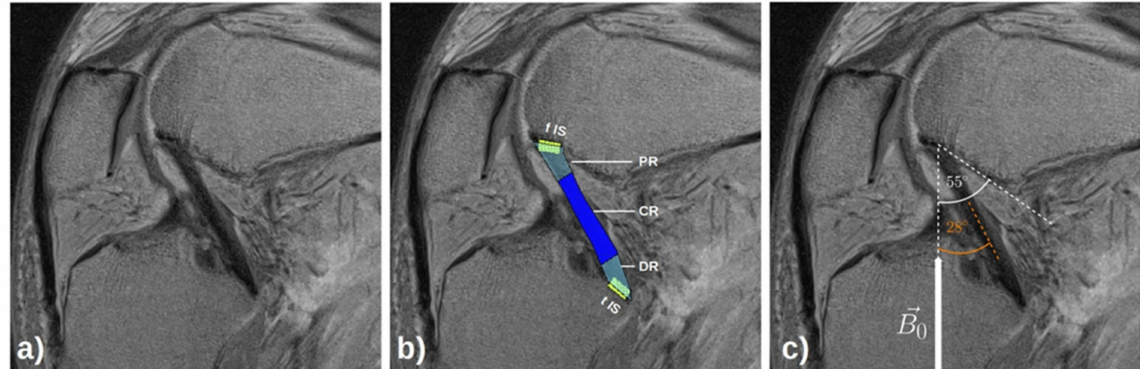
Figure 2. Exemplary visualization of the osseous and ligamentous regions-of-interest of the posterior cruciate ligament (PCL) and the orientation of the PCL to the main magnetic field B 0 . On the corresponding morphologic parasagittal image with moderate T2-weighting (echo time = 41.4 ms) ( a ), the PCL was identified and manually segmented. The PCL’s segmentation outline was automatically divided into quarters for further subregional analysis ( b ). The proximal 25% of the PCL was defined as the proximal subregion (PR, light blue), the central 50% as the central subregion (CR, blue), and the distal 25% as the distal subregion (DR, light blue). The femoral (fIS) and tibial insertion sites (tIS) of the PCL were positioned around the cortical bone of the respective insertion sites and are outlined by rectangular boxes (yellow). The white arrow indicates the orientation of the main magnetic field B 0 ( c ). The orange dashed lines indicates the principal orientation of the PCL and an angle of 28 ◦ (orange) was determined between the PCL and the main magnetic field. Similarly, the orientation of the magic angle of 55 ◦ with respect to B 0 is indicated by the white dashed lines. Same right knee joint specimen as in Figures 1 and 4 ( δ 1